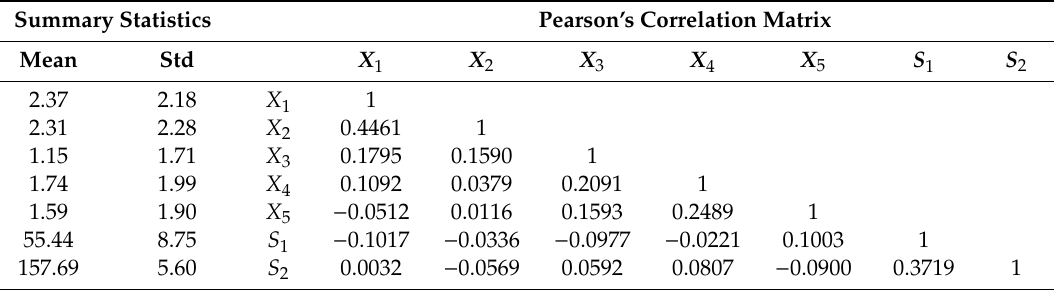
Table 5. Statistical information from the original survey